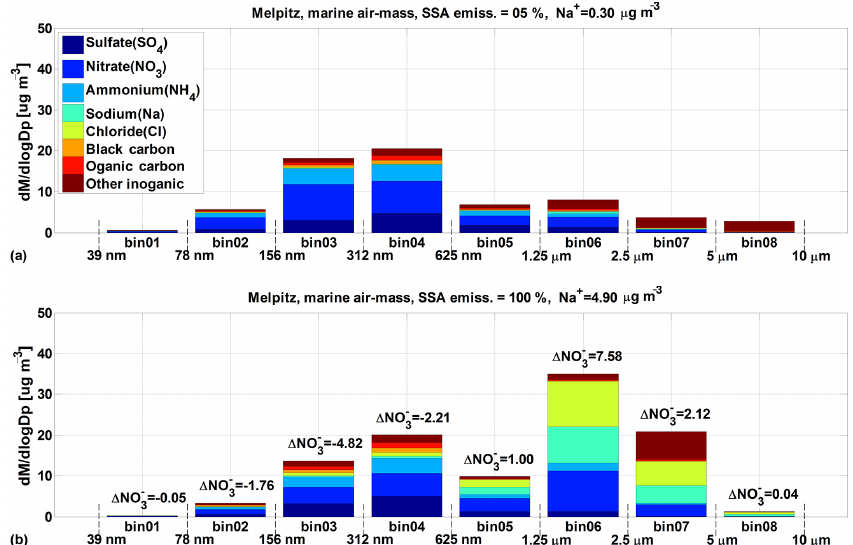
Figure 1. WRF-Chem simulation results of particle mass size distribution (PMSD) for each chemical compounds, averaged during marine period at Melpitz: (a) result of the R-CASE; (b) result of the F-CASE. The difference of nitrate PMSD between the R-CASE and the F-CASE for each bin is